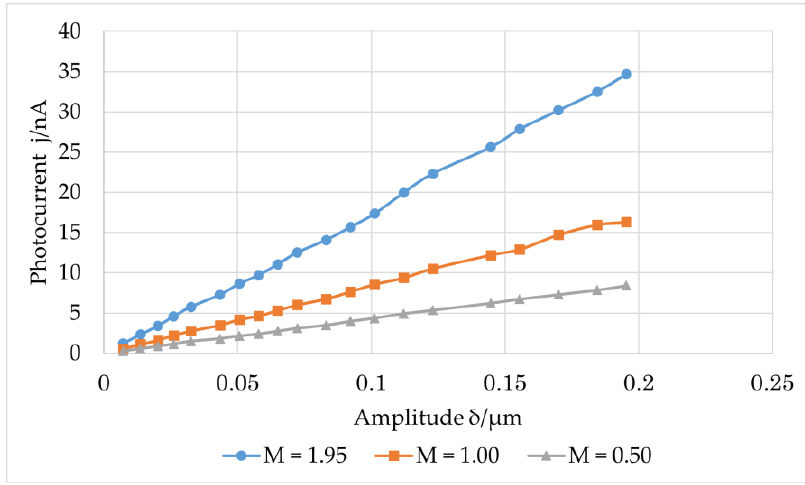
Figure 8. Relation between the amplitudes of the first harmonic of the photocurrent and vibration at different magnifications.